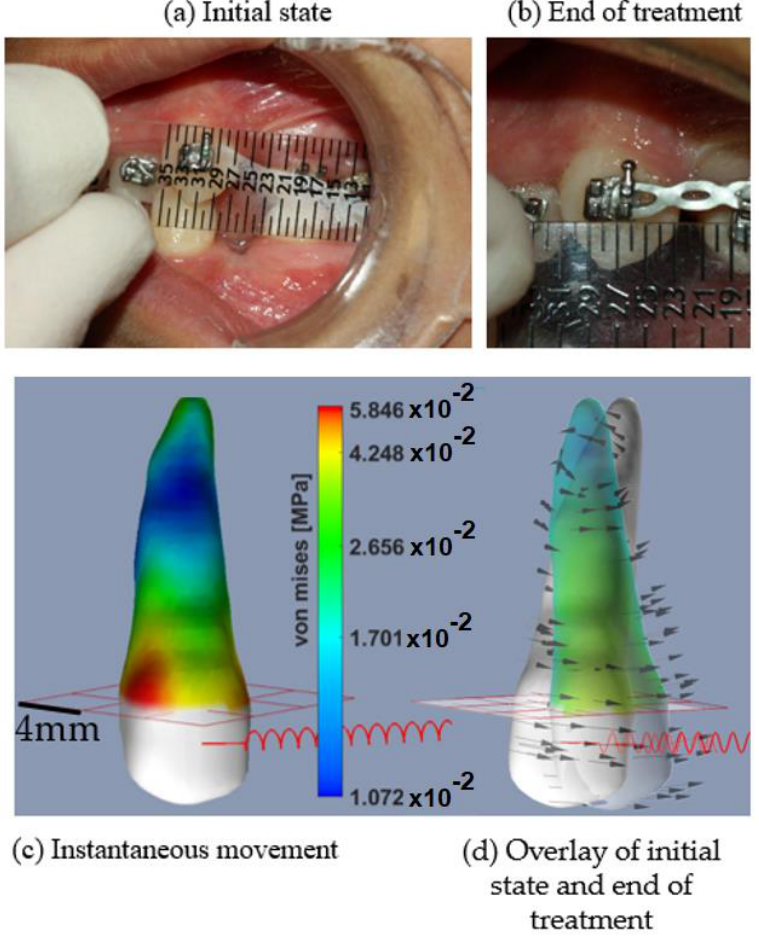
Figure 10. Comparison between a clinical case of orthodontic treatment conducted by one author and a model simulation ( a , b ). The clinical case before ( a ) and after treatment ( b ). The model at its initial configuration displaying the (von Mises) stresses before significant movement ( c ) and at the end of treatment, with an overlay of the original tooth position displayed in white ( d ). The gingival surface is displayed as a red mesh and the orthodontic appliance as a red coil. The applied initial force was 2.9 N, and the measured movement of the orthodontic tooth anchorage was approximately 4 mm. The anchorage is at the tooth power chain connection in ( a , b ) and at the edge of the red coil in ( c , d ). The tooth rotation angle was 0.045